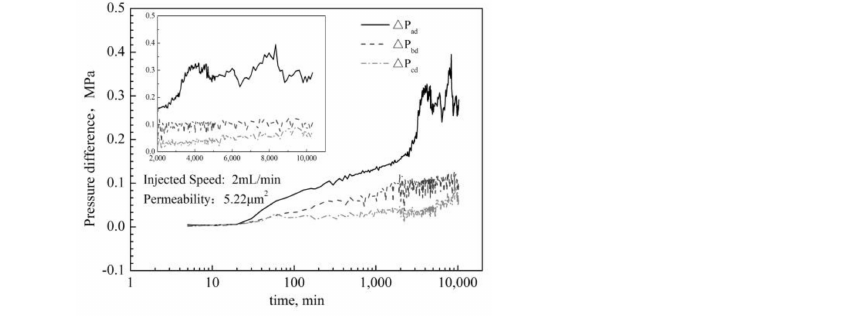
Figure 3. The curve of pressure difference vs. time under dynamic gelation in porous media.